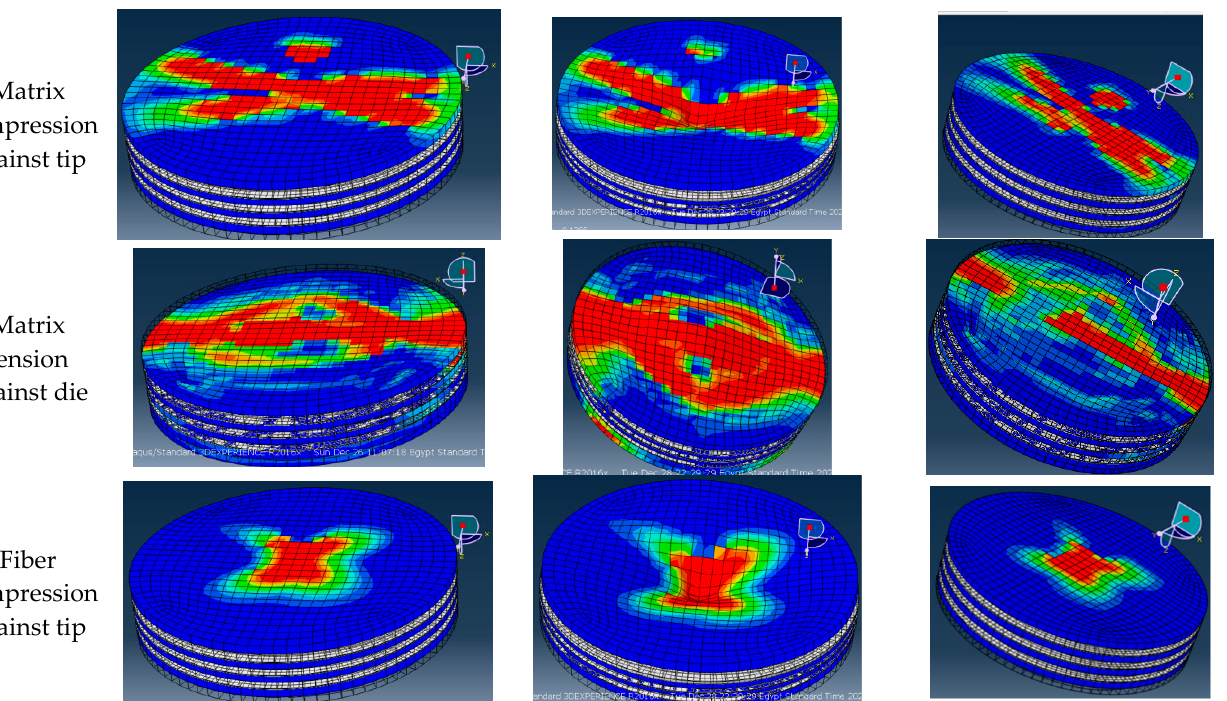
Figure 19. Comparison between the 30% V f % ordinary and FGM (specimens M 8 , M 10 , and M 11 ) failure elements.